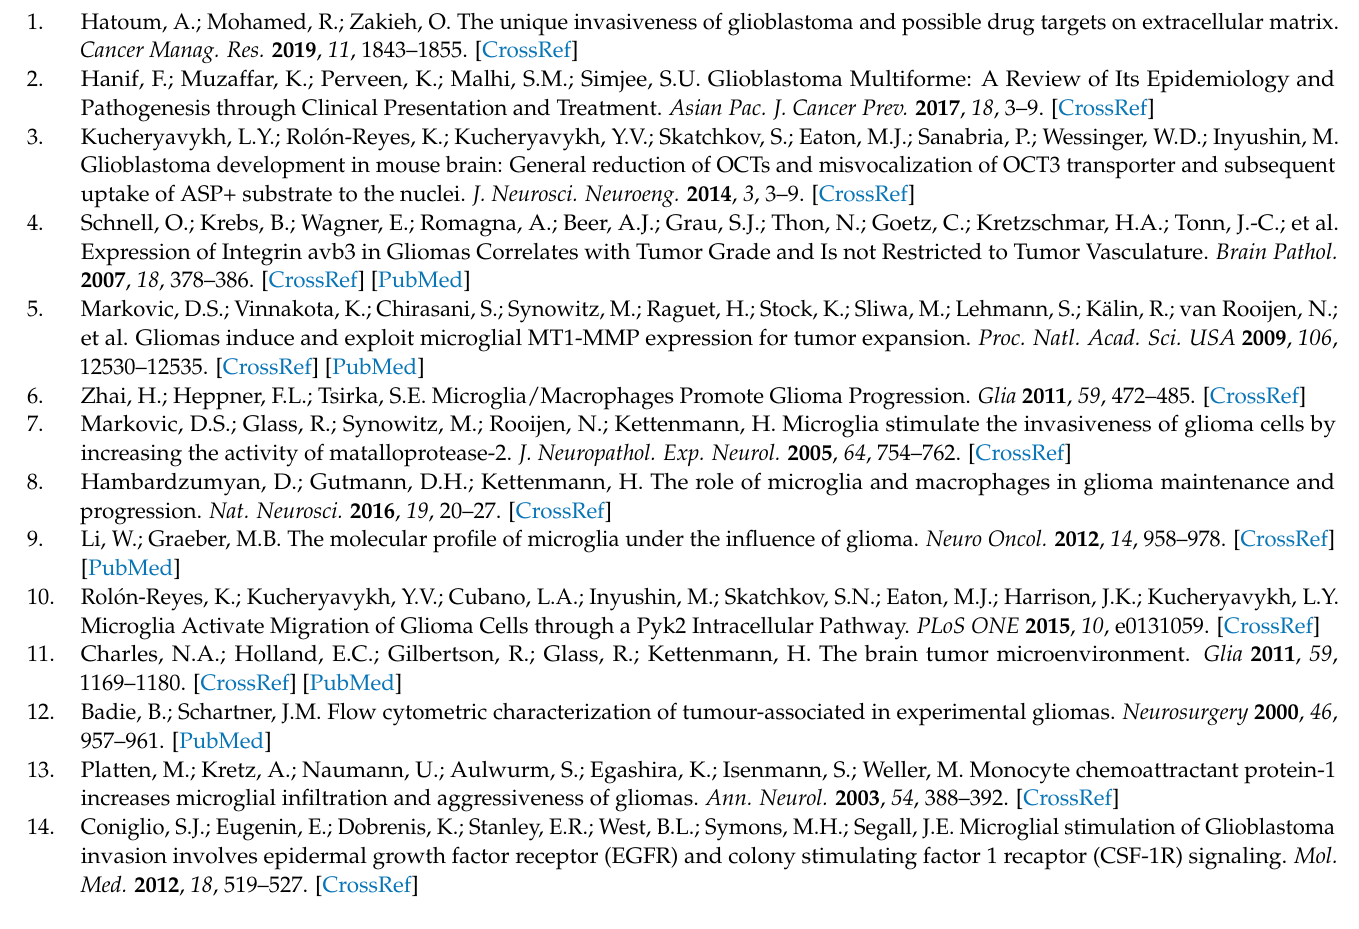
FAK, Figure S4: Uncropped western blot membranes for identification of Pyk2 and FAK in support of Figure 2, Figure S5: Efficacy of siRNA knockdown against Pyk2 and FAK in GBM derived primary cells, Figure S6: PDGF α -induced cell proliferation in CL3, Table S1: List of primers, used in